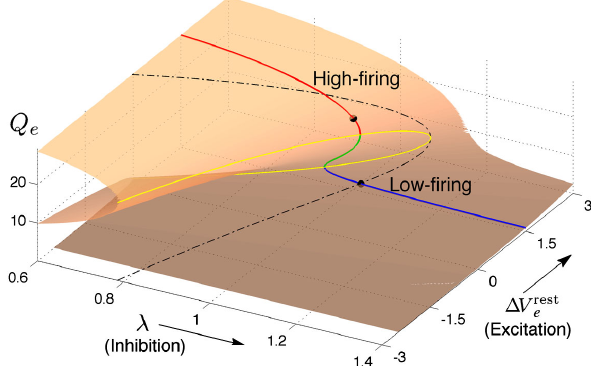
FIG. 2. Manifold of steady-state firing rates Q e across the ð (cid:13); (cid:1) V rest Þ anesthesia domain. The control parameter (cid:13) sets the anesthetic effect; (cid:1) V rest is an additive offset representing background cortical excitation ( (cid:1) V rest > 0 ) or suppression ( (cid:1) V rest < 0 ). The yellow curve marks the edge of the reentrant ‘‘fold’’; the dashed black curve shows the projection of this edge onto the lower and upper surfaces, bounding the zone of multiple steady states. The red-green-blue curve shows the distribution of steady states for varying anesthetic inhibition at constant cortical excitation (see Fig. 3).